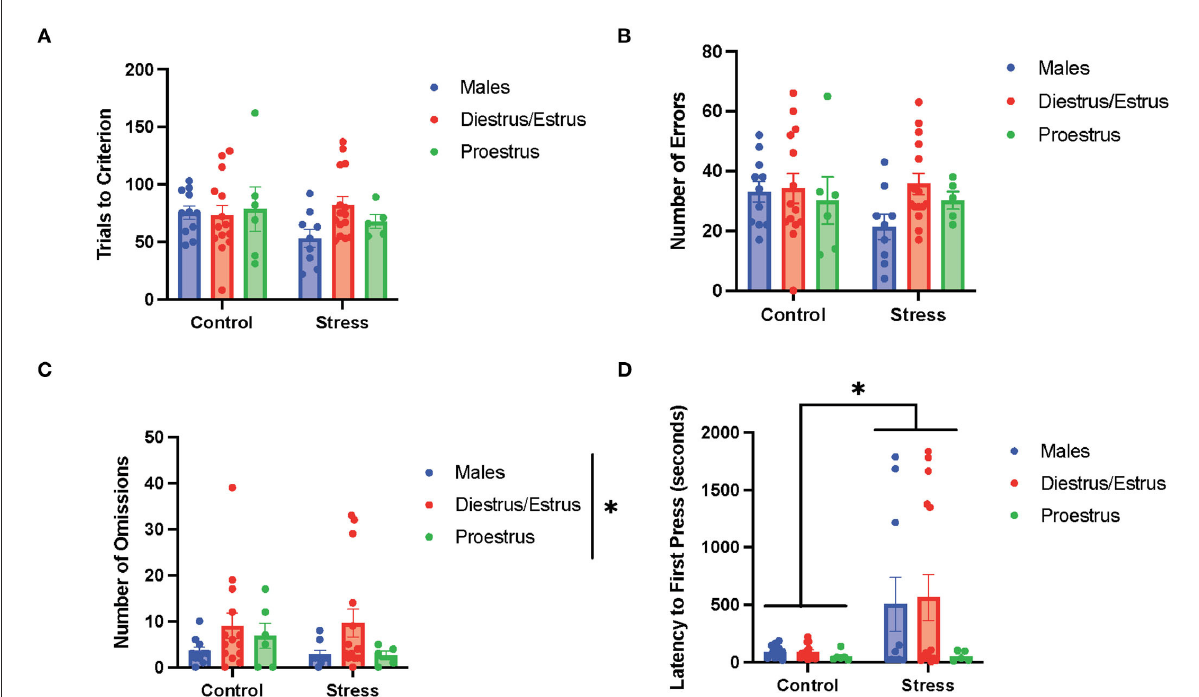
FIGURE5 Gonadal hormone status and acute stress impacted performance in the side discrimination task. (A) There were no effects of gonadal hormone status or acute stress on trials to criterion. (B) There were no effects of gonadal hormone status or acute stress on number of errors. (C) There was a main effect of gonadal hormone status on the number of omissions. Although the female rats appear to have higher omissions than the male rats in general, the post-hoc tests did not indicate that any particular group was significantly different from another. (D) Stress increased the latency to first press for the male and diestrus/estrus female rats. Two-way ANOVAs followed by Tukey post-hoc tests were conducted to examine the relationship between stress and gonadal hormone status, and the interaction between the two variables on the measurements of side discrimination task performance for the male ( n = 21, control = 11, stress = 10) and female ( n = 40: control diestrus/estrus = 14, control proestrus = 6, stress diestrus/estrus = 14, and stress proestrus = 6) rats. Error bars are plotted as mean ± SEM. * p < 0.05.